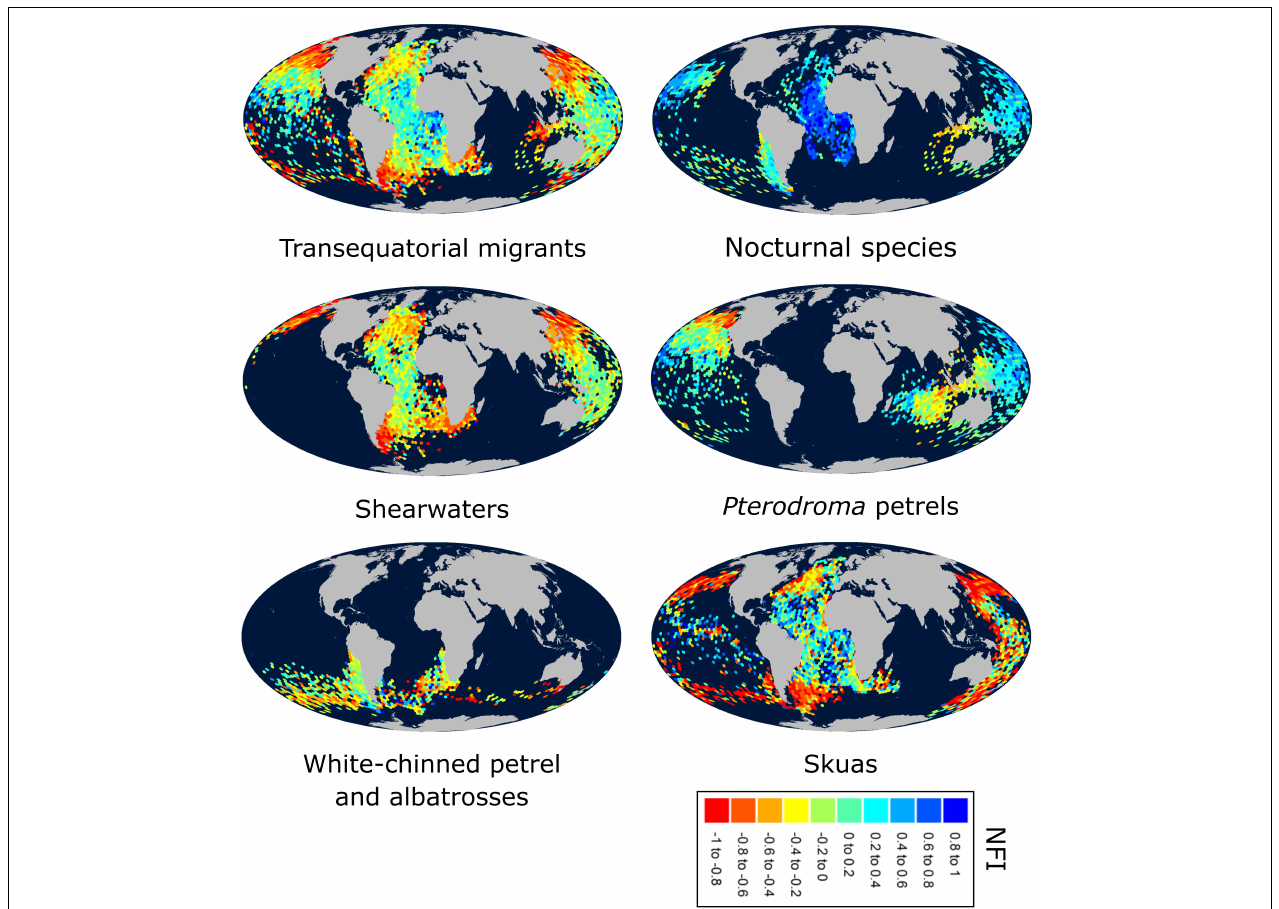
FIGURE 6 | Map of the night flight index (NFI) throughout the non-breeding season for different seabird groups. “Transequatorial” species: sooty shearwater, flesh-footed shearwater, Manx shearwater, great shearwater, short-tailed shearwater, Cape Verde shearwater, Cory’s shearwater, Leach’s storm petrel, Bulwer’s petrel, Cook’s petrel, black-winged petrel, Murphy’s petrel, long-tailed skua, south polar skua; “Nocturnal” species (generally positive NFI during the non-breeding period – see Supplementary Table 6 ): Bulwer’s petrel, black-winged petrel, white-chinned petrel, Leach’s storm